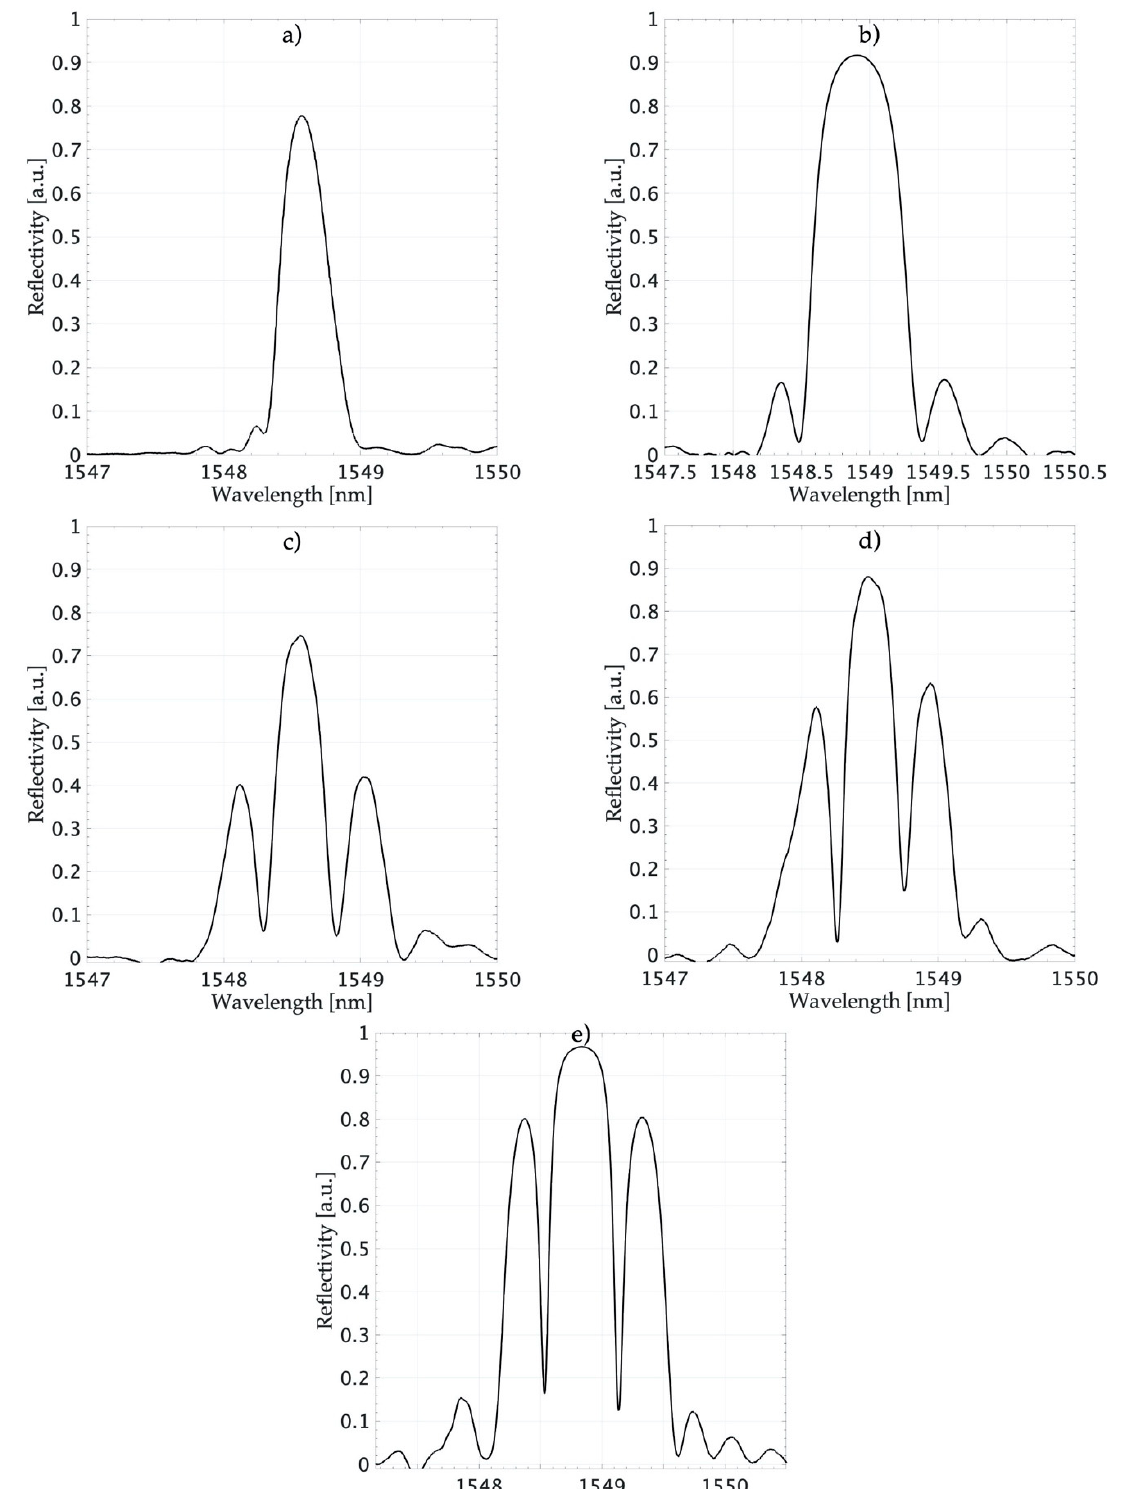
Figure 5. Spectral characteristics of fabricated FBGs: ( a ) FBG1; ( b ) FBG2; ( c ) FBG3; ( d ) FBG4; ( e )